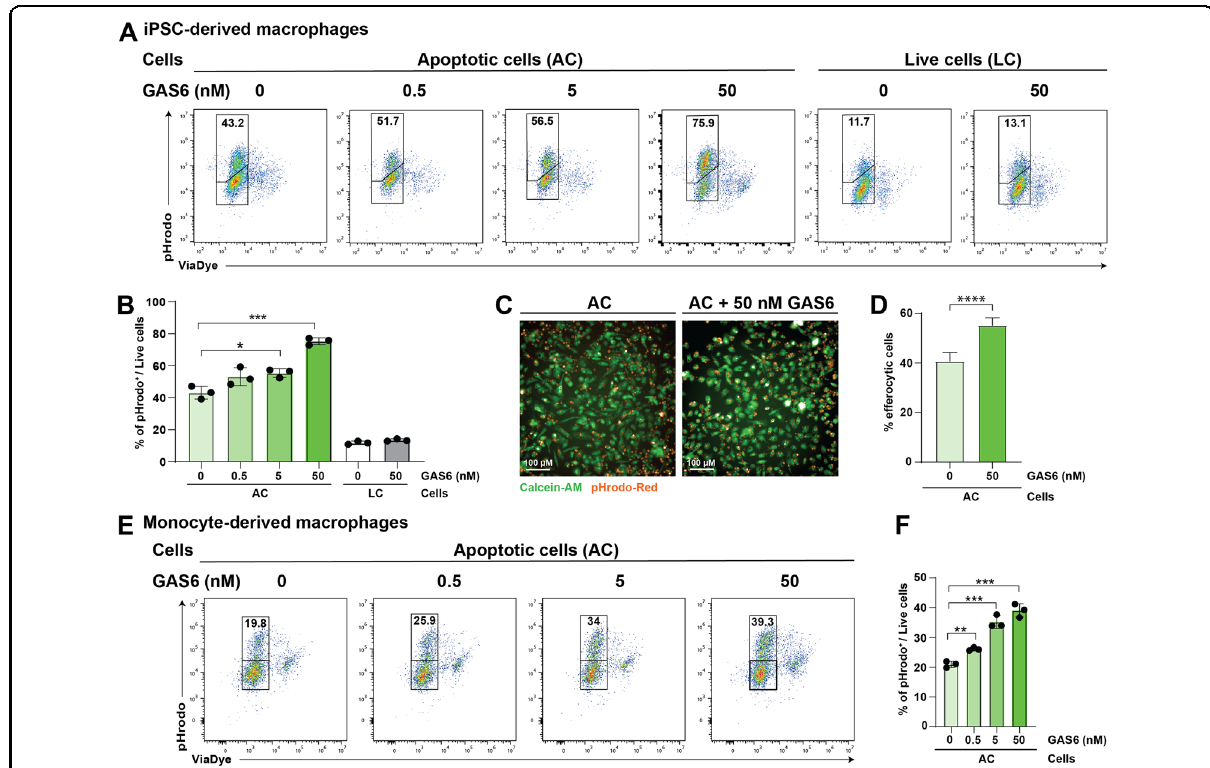
Fig. 2 GAS6 enhances efferocytosis in vitro in human iPSC-derived macrophages. A Flow cytometric analysis of efferocytosis in vitro using iPSC-derived macrophages. Apoptotic cells (ACs) were generated as described and live cells (LC) were used as control. ACs were labeled with indicated concentrations of GAS6. For LCs, GAS6 was added soluble. Macrophages and ACs were cultured for 2 h at a ratio of 1:6 and analyzed afterwards for pHrodo signal. B Frequency of pHrodo + macrophages. Bar graphs show mean with SD and individual samples. C High content imaging to determine frequency of efferocytic macrophages. Macrophages were stained with Calcein-AM prior to the assay. ACs were labeled with indicated concentrations of GAS6 and added to macrophages for 2 h. Afterwards, efferocytic macrophages were quanti fi ed using the Operetta CLS High-Content Analysis system. D Frequency of pHrodo + macrophages. Bar graphs show mean with SD. E Flow cytometric analysis of efferocytosis in vitro using monocyte-derived macrophages. F Frequency of pHrodo + macrophages. Bar graphs show mean with SD and individual samples. All experiments have been performed with three ( fl ow cytometry) or 32 (imaging) technical replicates. Data were representative of at least three individual